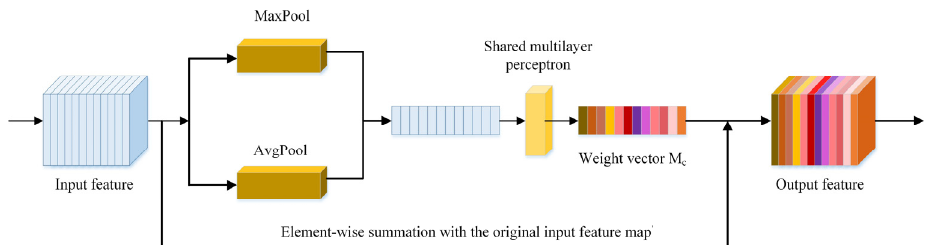
Figure 8. The structure of channel attention module.